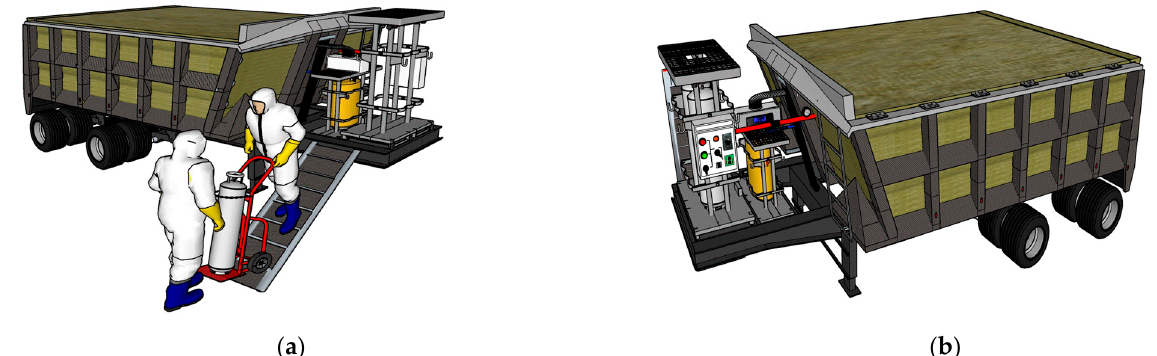
Figure 9. Replacement of CO 2 liquid and propane cylinders is aided by the use of a foldable ramp. ( a ) Replacement of a gas cylinder using a foldable ramp. ( b ) The foldable ramp is returned to a fixed position after replacing cylinders. The unit is ready for multiple uses on a single, properly sized cylinders for CO 2 and propane.